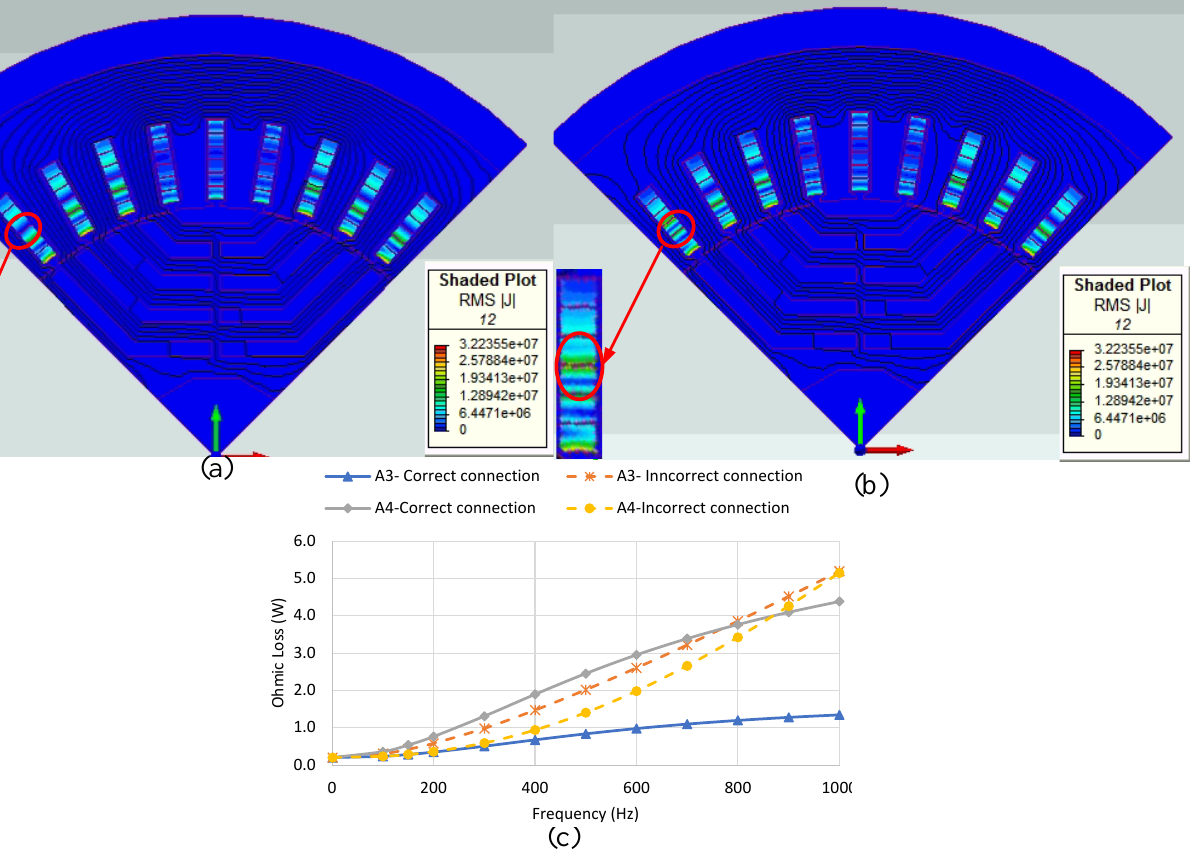
Figure 5. ( a ) FEA results of correct transposition of windings for 1 kHz, ( b ) FEA results of incorrect transposition of windings for 1 kHz, and ( c ) ohmic losses versus frequency in A3 and A4 conductors with correct and incorrect transposition of windings.